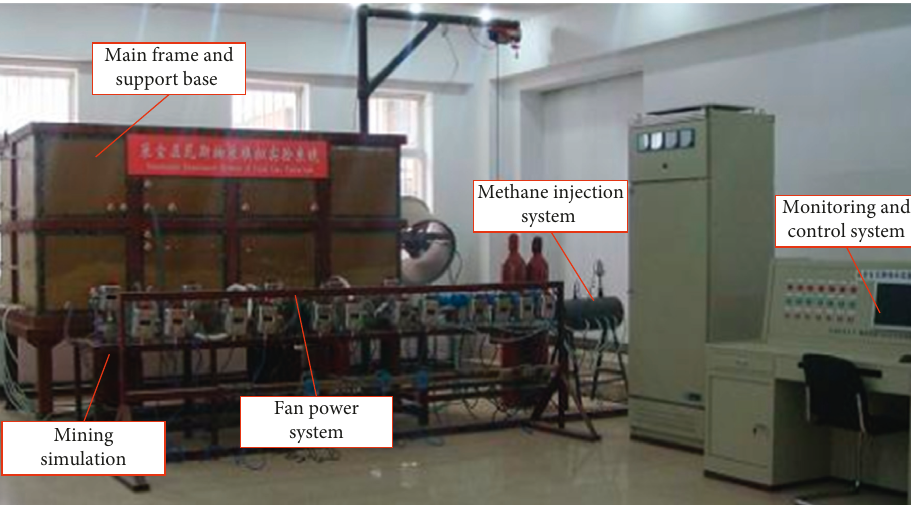
Figure 10: Simulation experimental system for gob methane extraction [14,